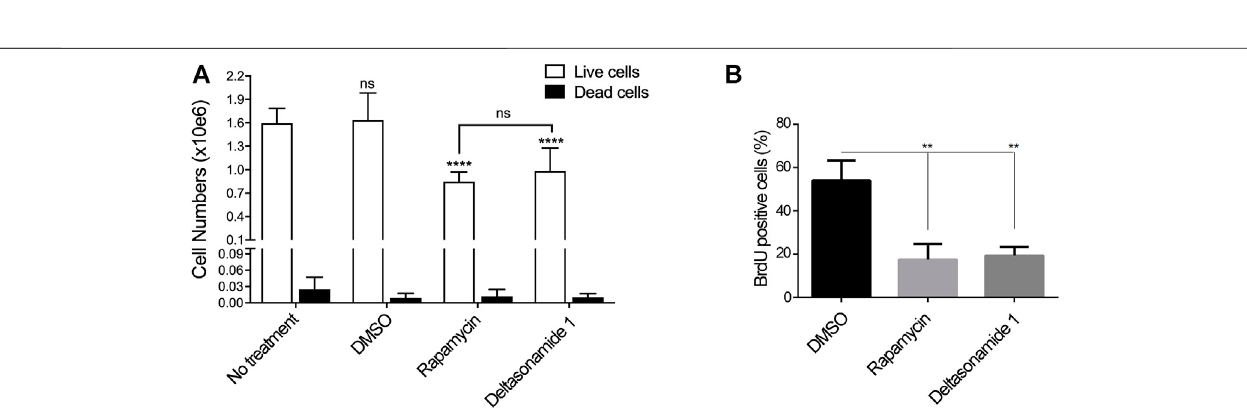
FIGURE 4 | Deltasonamide 1 inhibits Tsc2-null MEFs proliferation (A) . Tsc2-null MEFs treated with DMSO, Deltasonamide 1 (6 µM) or rapamycin (20 nM) for 24 h. After drug treatment, live and dead cell numbers were marked with Live/DeadTM Fixable Green Dead Cell staining assay and analyzed with an automated cell counter (B) . Tsc2-null MEFs treated as in (A) . The graph shows the percentage of 5-Bromo-2-deoxyuridine (BrdU) positive cells after treatment. Results are representative of at least three independent experiments. Data are expressed as the mean ± SD ( p < 0.05).